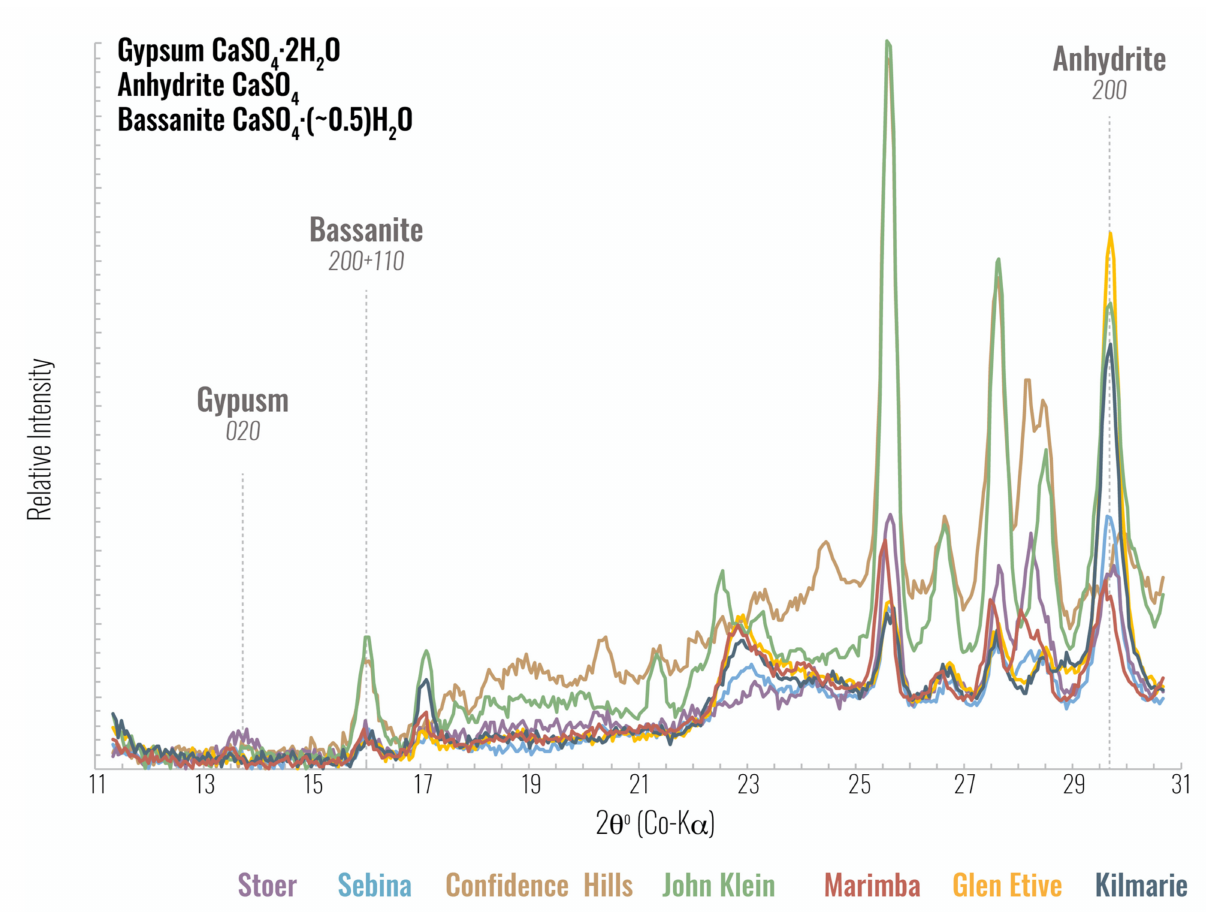
Figure 6. X-ray diffraction patterns for select mudstone drills throughout Curiosity’s traverse. The 2 θ range is restricted to highlight the key sulfate reflections that the CheMin team uses to identify discrete phases. The location of XRD peaks for the most common sulfate minerals identified are illustrated with dotted